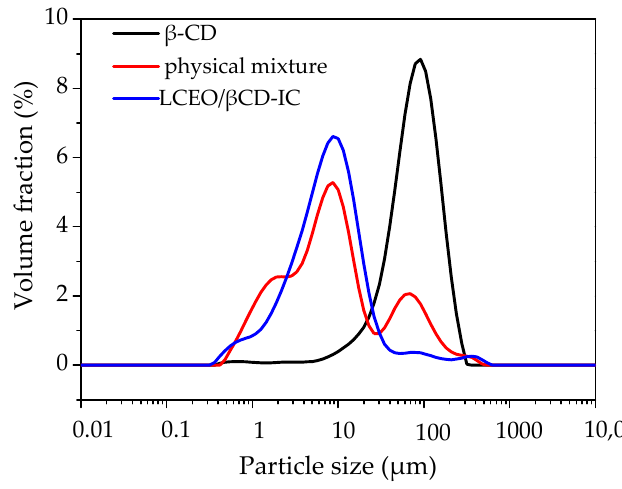
Figure 6. Distribution of particle sizes of β -CD, physical mixture and the LCEO/ β -CD inclusion complex.